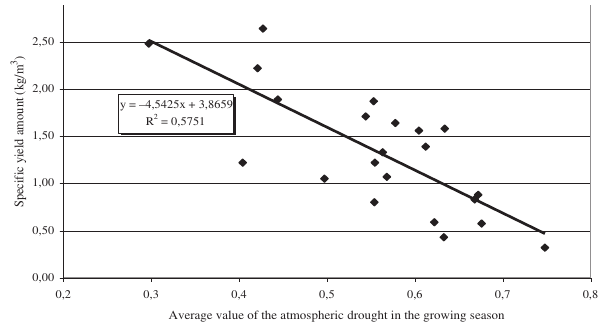
Figure 2 – Correlation between the specifi c yield of the sour cherry variety Újfehértói fürtös and the index of atmospheric drought at Újfehértó (1989–2011)